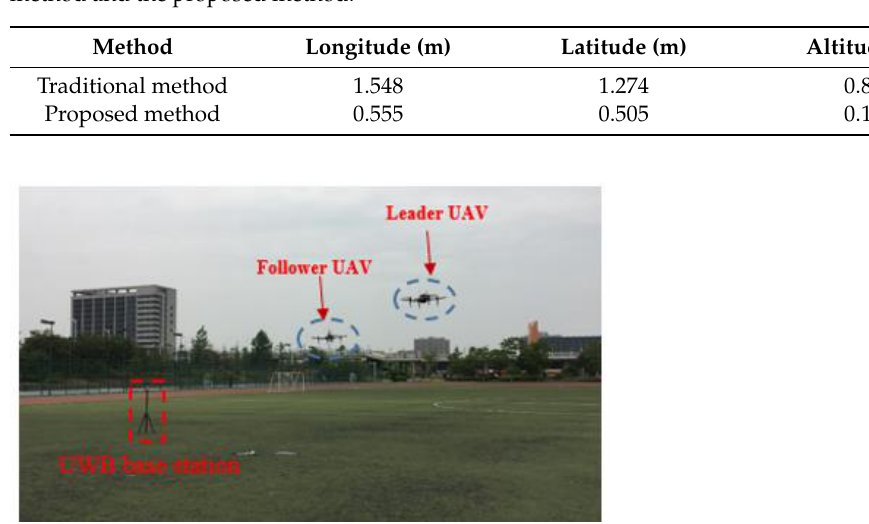
Figure 5. Sensor mounted on the UAVs in autonomous flight experiment. Table 1. The performance parameters of airborne sensors in the experiment.